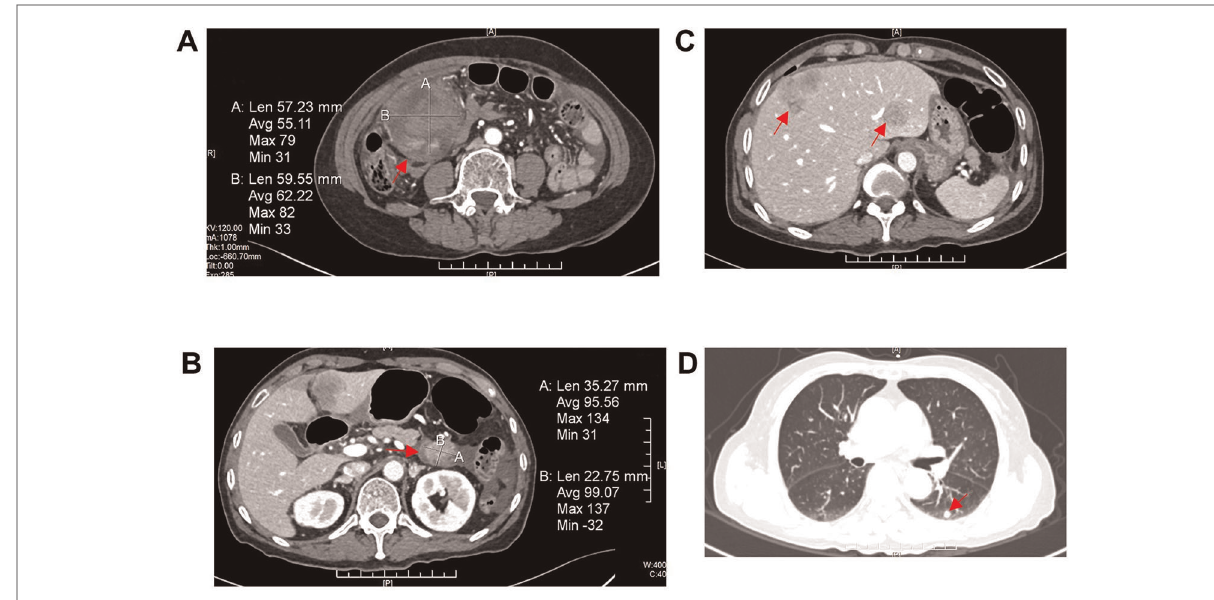
FIGURE 2 Enhanced CT of the chest and the whole abdomen showed tumor recurrence and extensive systemic metastases ( A ). Therewas a mixed density mass in the right middle abdomens, and the boundary was not clear (red arrowheads). ( B ) A cystic and solid mass was found next to the duodenum, irregular in shape, with unclear demarcation with the duodenum, and the solid part was signi fi cantly enhanced (red arrowheads). ( C ) There were several nodular and clump-shaped hypodense shadows in the liver, and the larger ones were located in the right lobe of the liver (red arrowheads). ( D ) There were multiple solid nodules in both lungs, and the largest one was located in the dorsal segment of the left lower lobe (red arrowheads). CT, computed